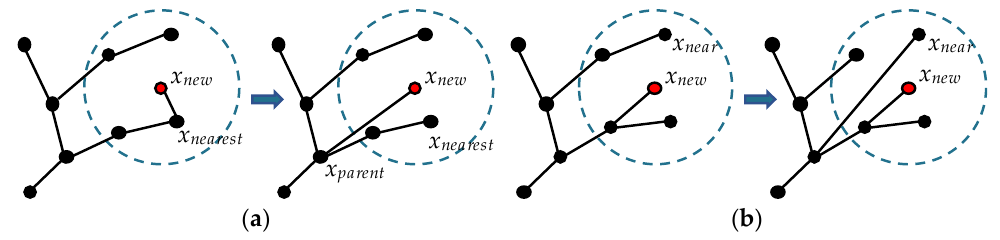
Figure 3. ( a ) ChooseParent (Q-RRT*); ( b ) Rewire (Q-RRT*).